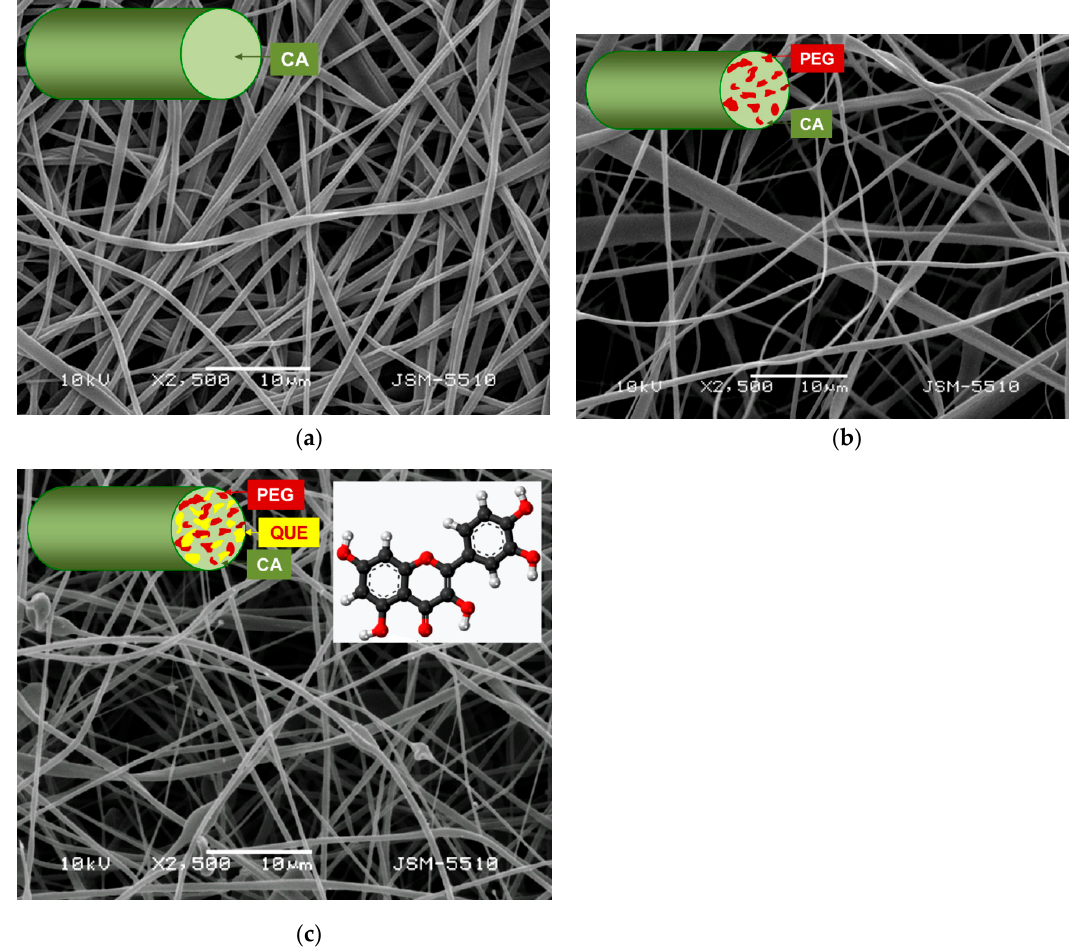
Figure 1. Micrographs of the fibers: ( a ) CA, ( b ) CA / PEG, and ( c ) CA / PEG / QUE and their schematic representation (insets).